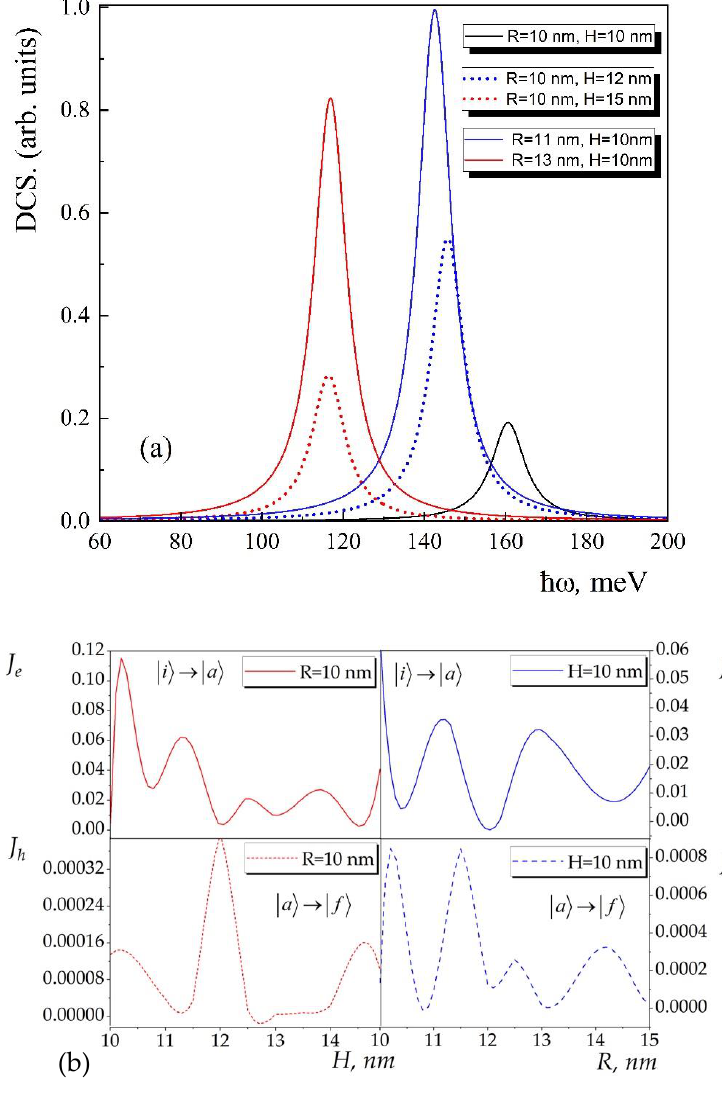
Figure 7. Exciton-related Raman DCS as a function of secondary-radiation photon energy for different sizes of GaAs conical QD ( a ) and overlap integrals as a function of the geometrical parameters H and R for the transitions | i (cid:105) → | a (cid:105) and | a (cid:105) → | f (cid:105) ( b